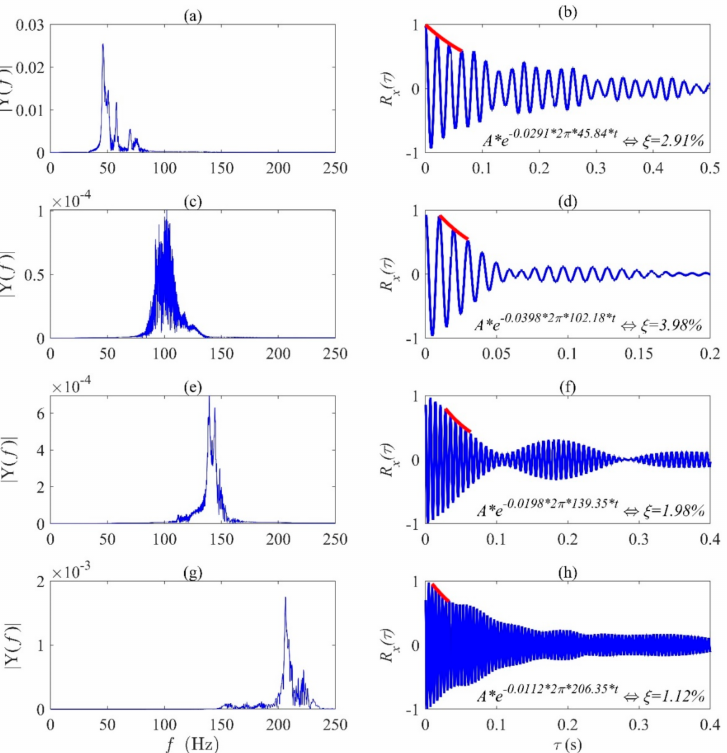
Figure 15. Fourier spectra and ACF of IMFs extracted from a 4 sensor of test #K conducted on the wind turbine blade; ( a , b ) IMF1; ( c , d ) IMF2; ( e , f ) IMF3; ( g , h ) IMF4.